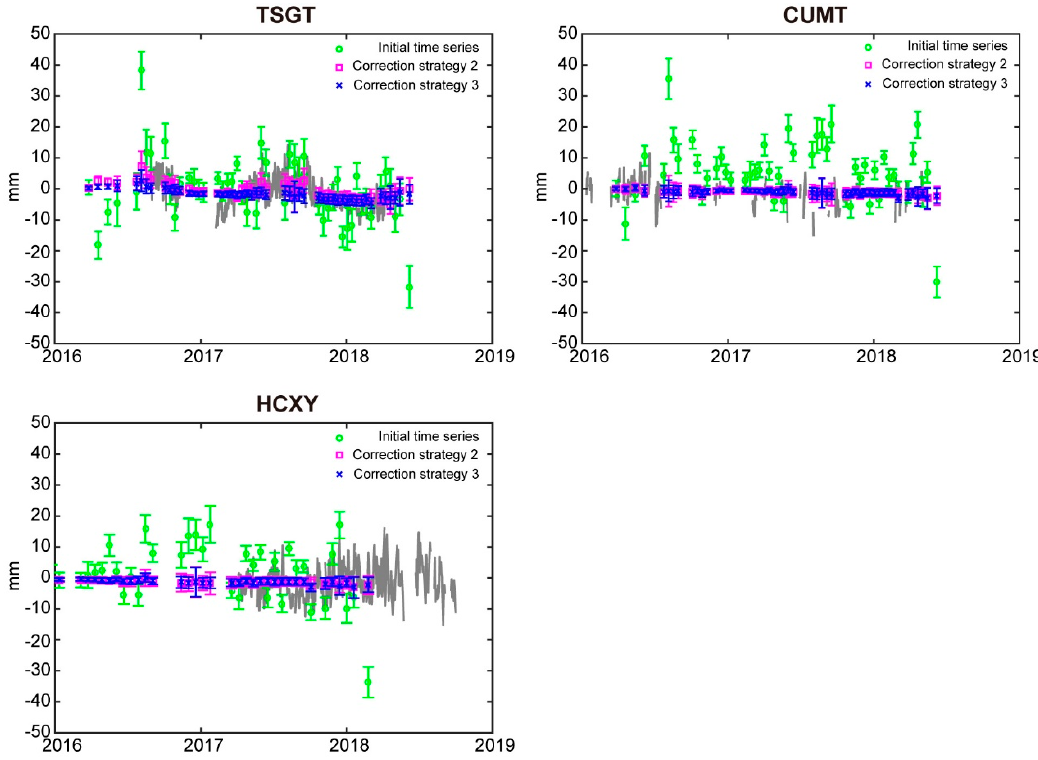
Figure 5. Line-of-sight displacement comparison between GNSS and InSAR time series derived from different strategies at stations TSGT, CUMT and HCXY (see Figure 1 for locations). Gray lines in the background indicate GNSS measurements. Green circles, magenta squares and blue crosses indicate the measurements of the initial InSAR time series and the InSAR time series corrected by Strategies 2 and 3, respectively. Error bars represent standard deviations within 20 m neighboring areas.